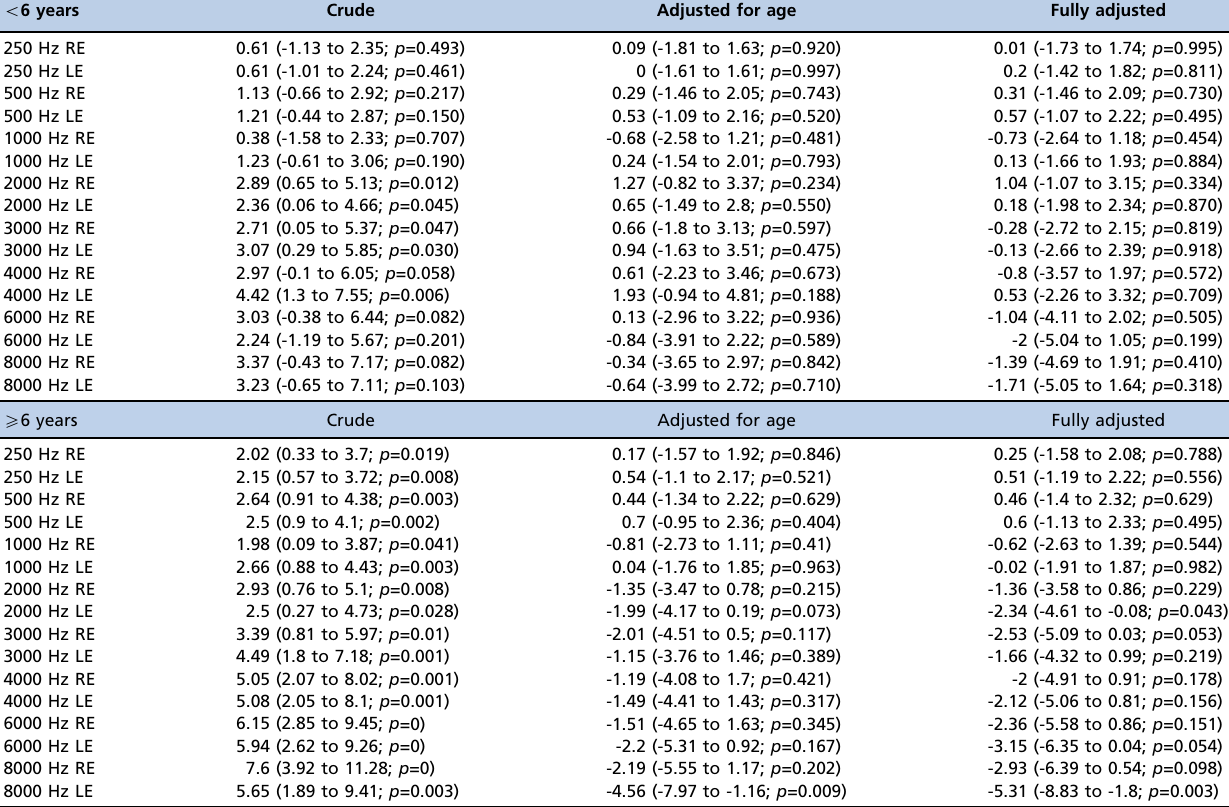
Table 3 - Beta-coefficients for the association between mean audiometric measurements and hypertension with time from the diagnosis o 6 years (N=141) and X 6 years (n=153) in the crude and adjusted models.